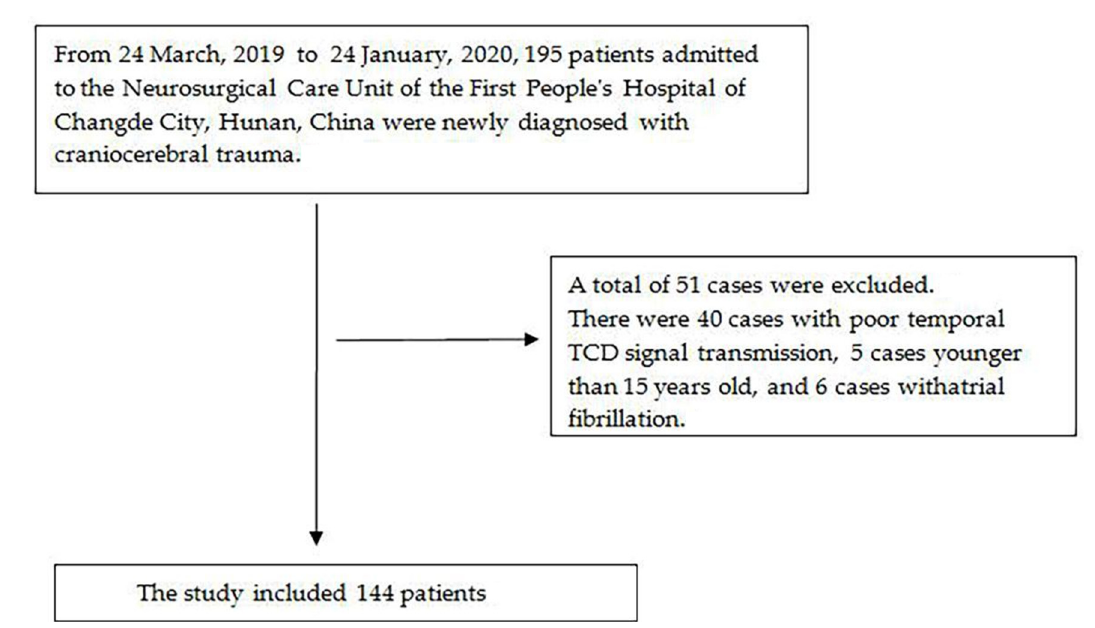
Figure 1. Flow chart.